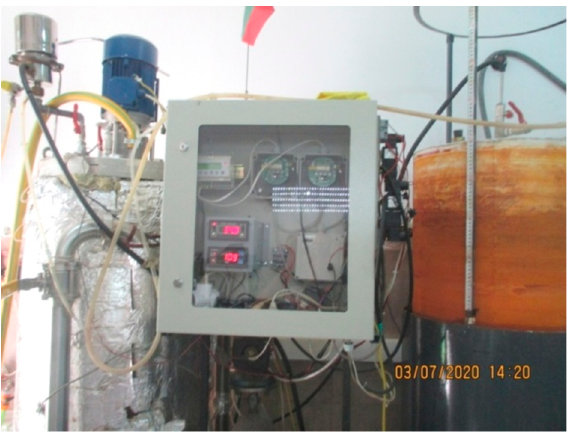
Figure 3. General view of BR 2 , GH, and measuring board.